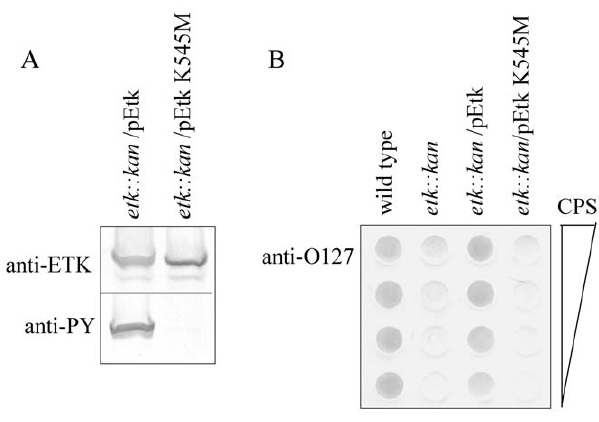
Figure 1. Etk K545M mutant failed to support capsule production. EPEC strains, including wild type, etk::kan mutant and the mutant complemented with plasmids pOI277 (pEtk) or pMS3239 (pEtk K545M), were grown under conditions that allowed capsule production. After harvesting, proteins and capsular polysaccharide were extracted. (A) The amount of Etk and phosphorylated Etk were assessed by Western blot using anti-Etk and anti-phosphotyrosine (anti-PY) antibodies. Each lane is labeled with the strain (above blot) and antibody (on left). (B) Purified capsular polysaccharide extracted from bacteria was serially diluted to generate a dot blot that was developed with anti-O127 antibody. Wild-type EPEC and etk mutant were used as positive and negative controls, respectively. The strains are